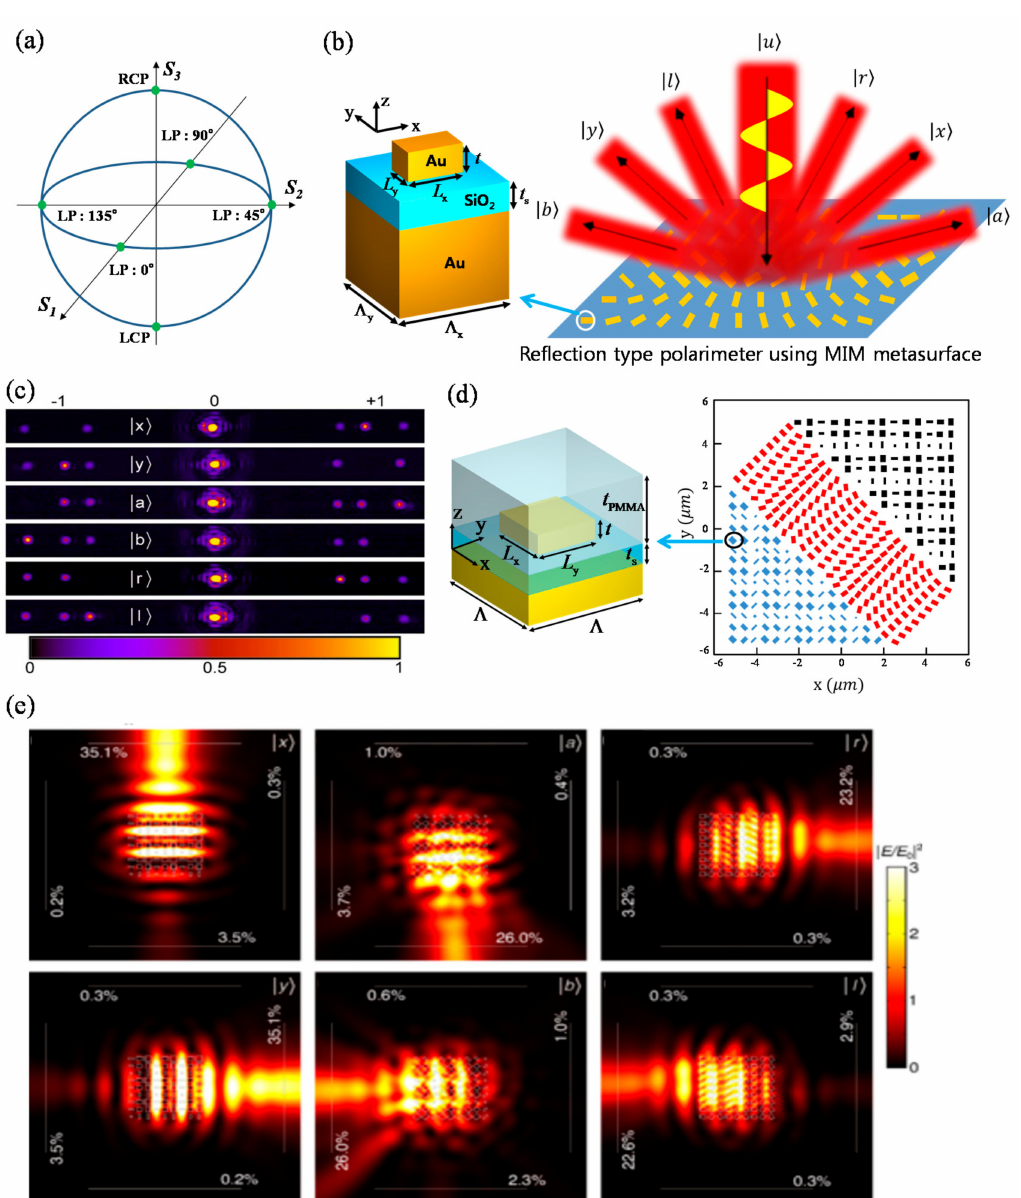
Figure 14. ( a ) Poincare sphere with four linear polarizations (LPs) and left circular polarization (LCP) and right circular polarization (RCP) as the six green dots; ( b ) Schematic illustration of reflection-type MIM MS polarimeter by A. Porst et al. [169]; ( c ) Far-field reflection images for the six different polarization states; ( d ) Scheme of reflective MIM MS in-plane polarimeter [170]; ( e ) Numerically calculated SPP excitation patterns when the three different unit-cells of MIM in-plane polarimeter are illuminated by the six differently polarized light. The first, second, and third column images correspond to the cases of the unit-cells for the black, blue, and red regions in ( d ). The upper right kets written in the six images denote polarizations state of incident beam. From Reference [169]. The part ( e ) is reprinted by permission from Reference